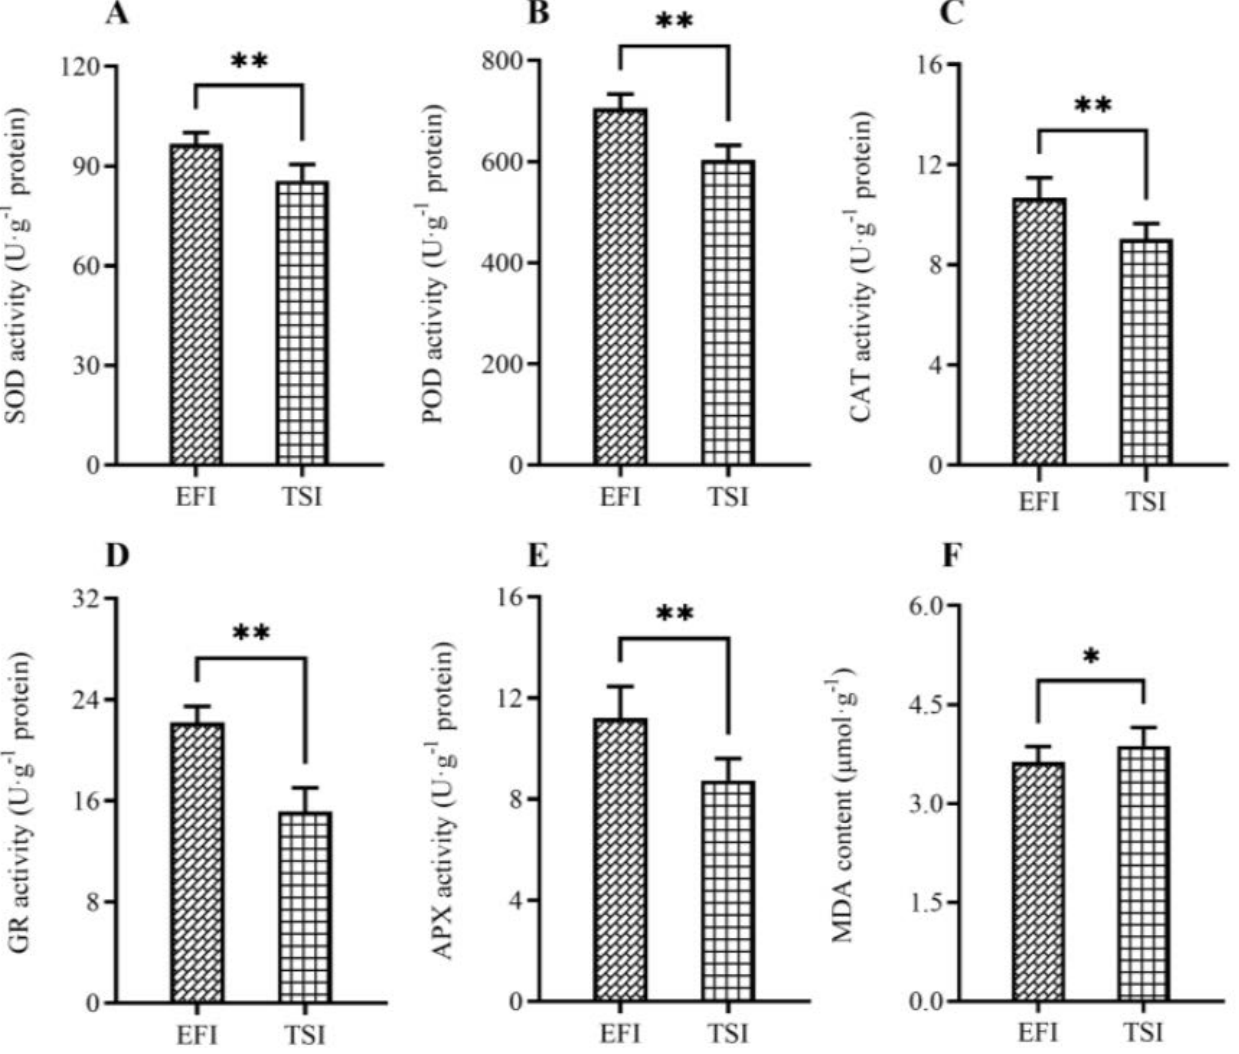
Figure 8. Effect of ebb-and-flow (EFI) irrigation and top sprinkle irrigation (TSI) on the activities of SOD ( A ), POD ( B ), CAT ( C ), GR ( D ), APX ( E ), and MDA content ( F ) of tomato roots. * and ** represent significance at p ≤ 0.05 and p ≤ 0.01, respectively.